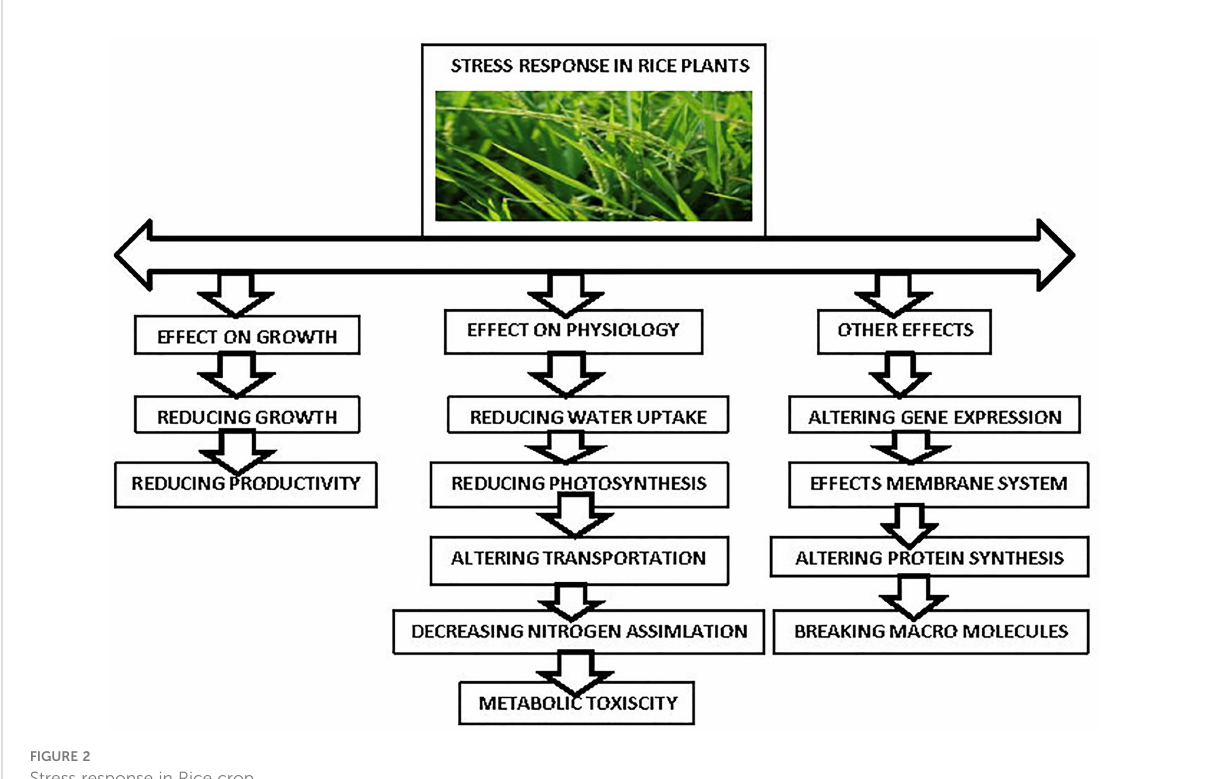
FIGURE 2 Stress response in Rice